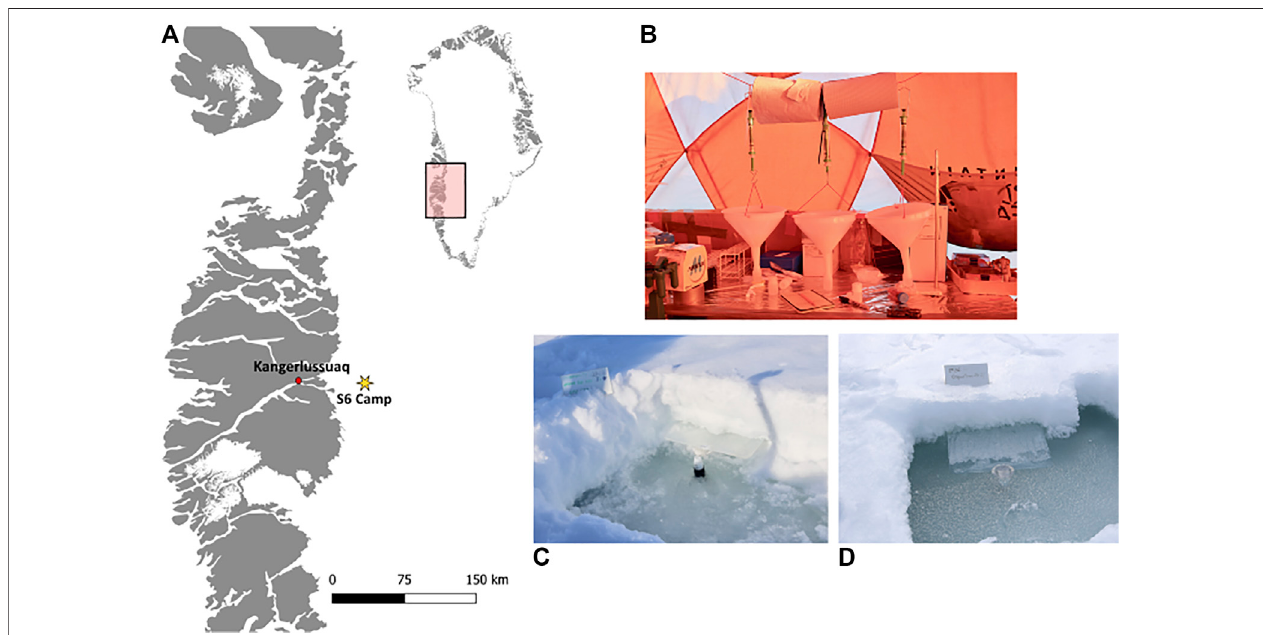
FIGURE 2 | Camp location on the south-west margin of the GrIS (A) , with inserts showing the crude laboratory snowmelt experiment (B) , the in-situ snow pack meltwater collection (C) , as well as the fl ooded in-situ snow pack meltwater (D) .